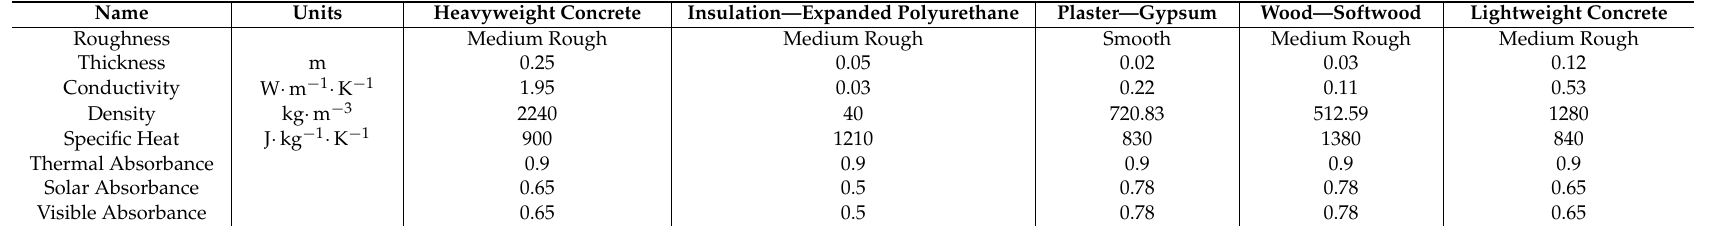
Table 2. Modeling construction materials and properties used for the building simulations.